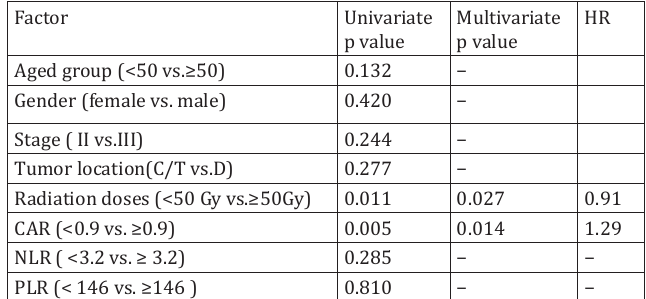
Outcomes of univariate and multivariate analysis for DFS